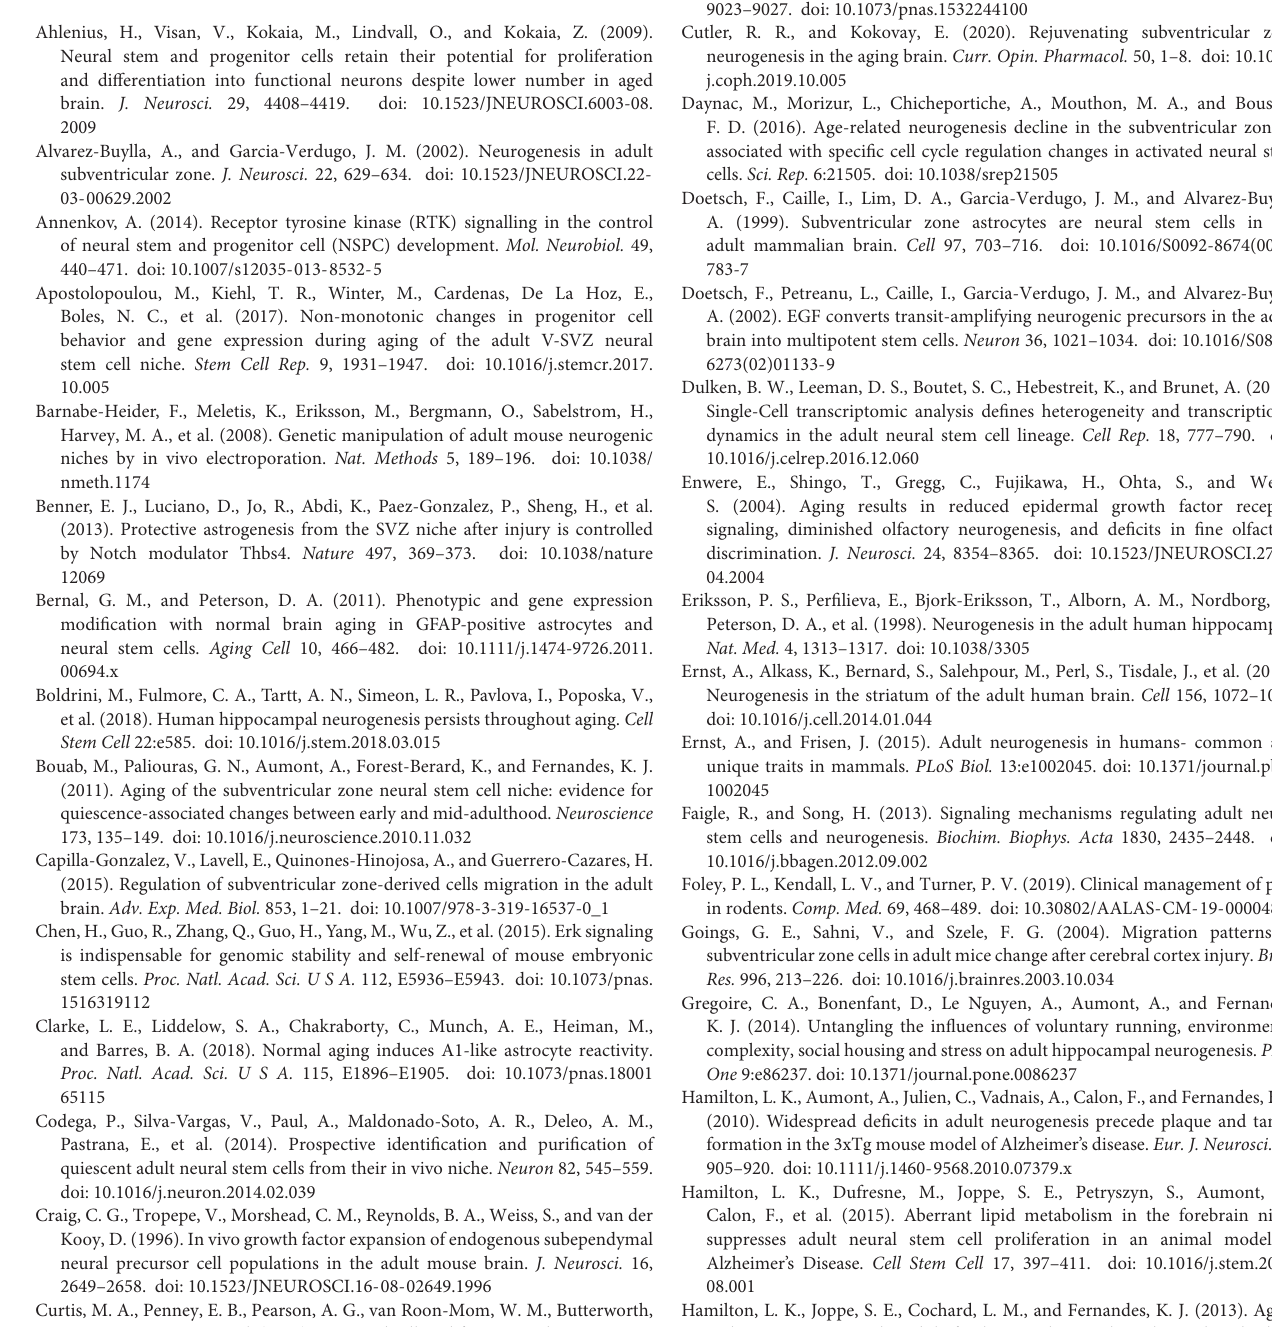
micrograph) and caudal side (right micrograph). The blue dotted square (a) represents region collected for the striatum and the green dotted shape (b) represents the region collected for the